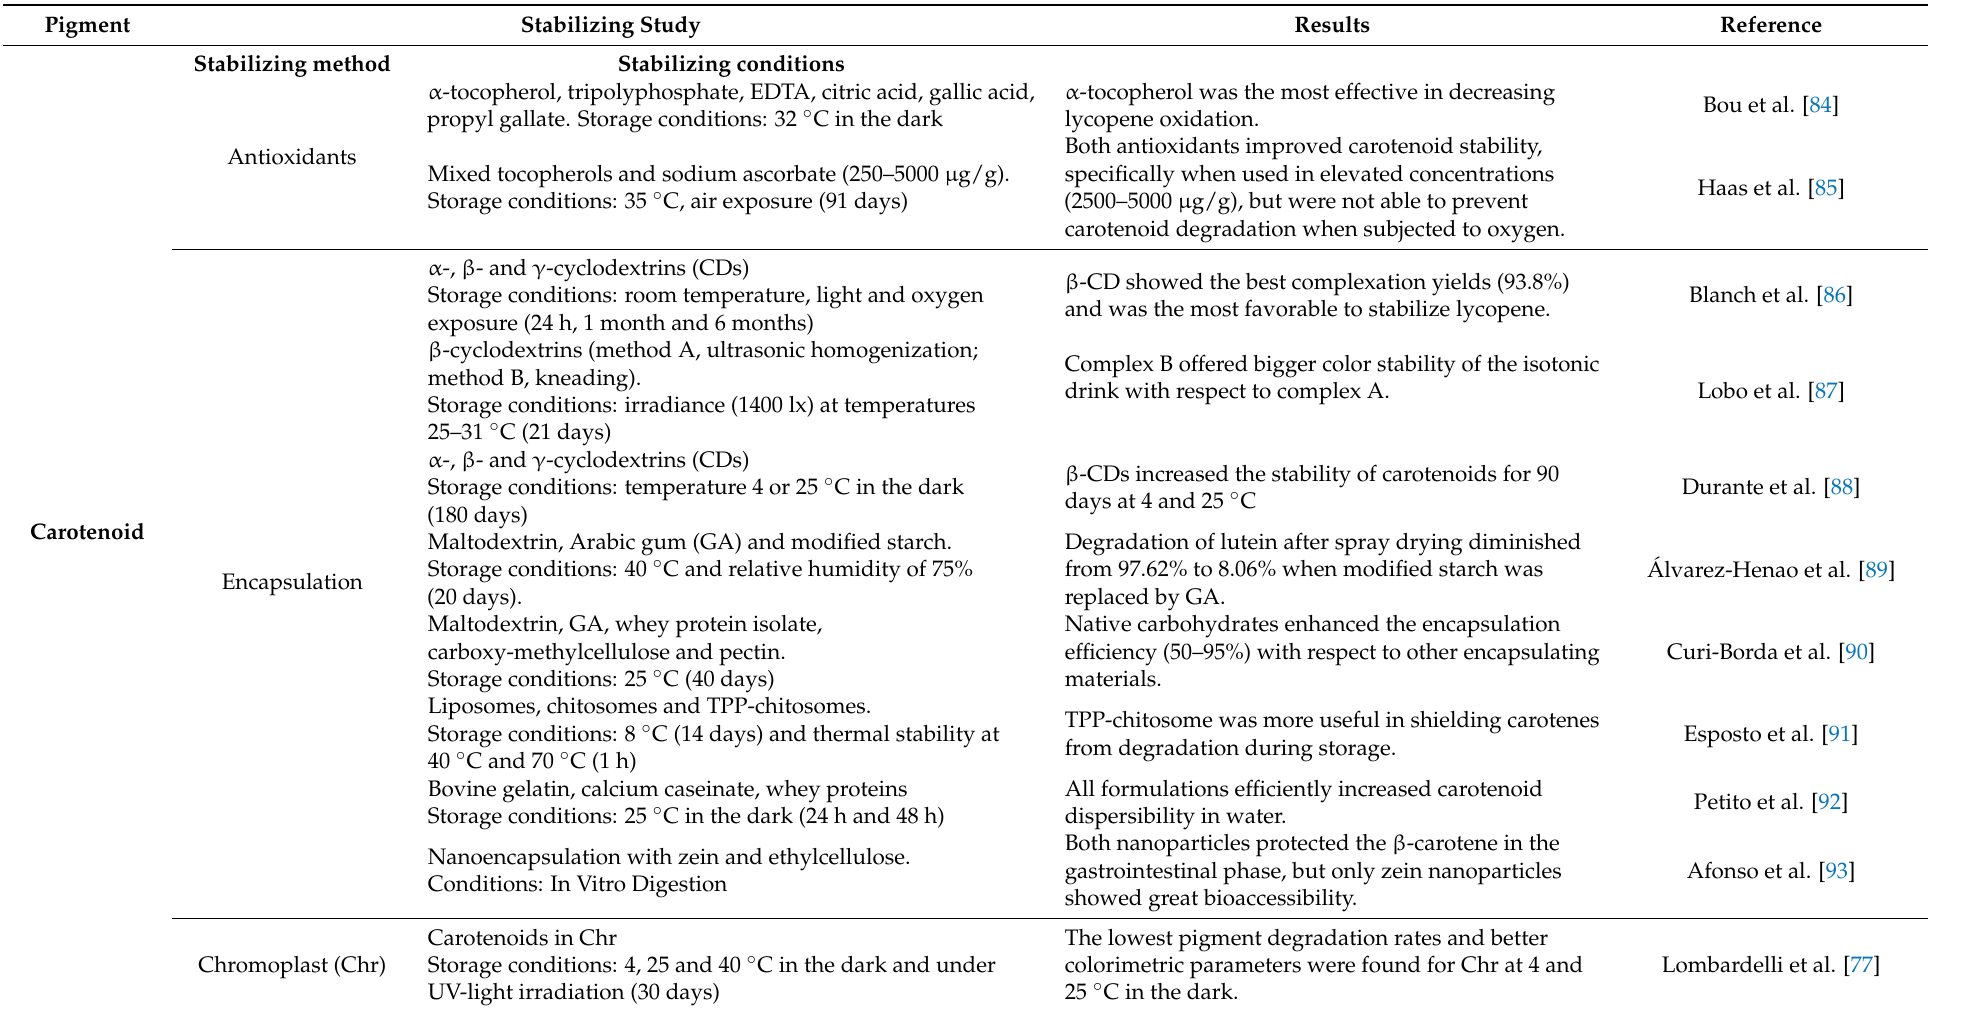
Table 2. Overview of recent studies about carotenoids and betalains